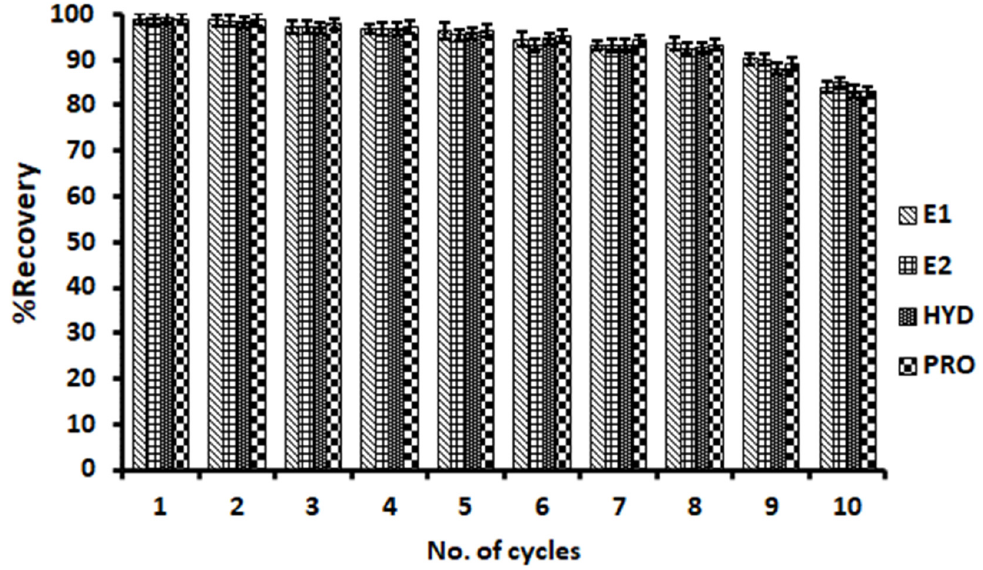
Figure 9. Regeneration of β -cyclodextrin-decorated magnetic activated carbon composite (initial concentration: C 0 = 100 µg L − 1 ) ( n = 3).